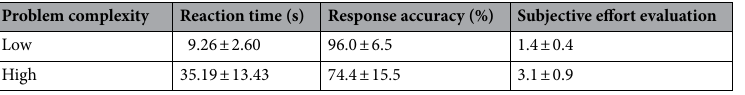
Table 1. Mean reaction time, response accuracy and subjective effort evaluation for the low and high complexity problems.